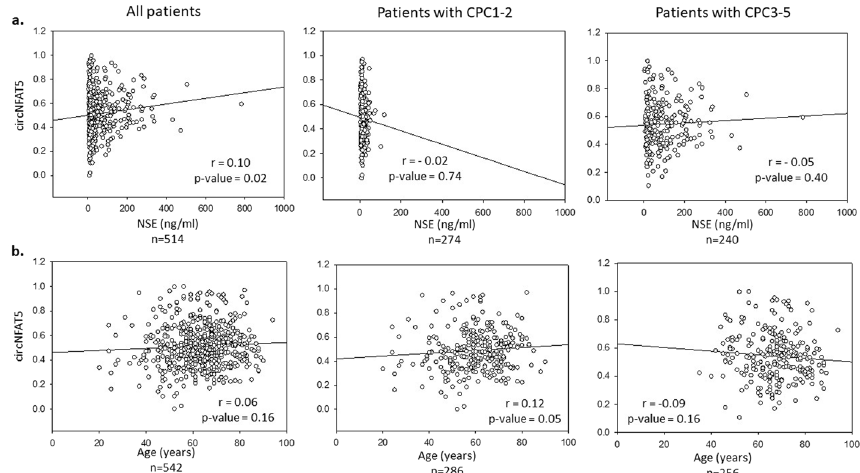
Fig. 4 Correlation analyses of circNFAT5 with NSE and age. Scatter plots and linear regressions showing the correlations between circNFAT5, NSE ( a ) and age ( b ). Correlations were conducted considering all patients or patients dichotomized according to neurological outcome as CPC 1–2 and CPC 3–5. The expression levels of circNFAT5 used for these analyses were normalized, log2 transformed and scaled. circNFAT5 and NSE levels were measured 48 h after OHCA. Spearman correlation coefficients (r) and p ‑value are indicated in each